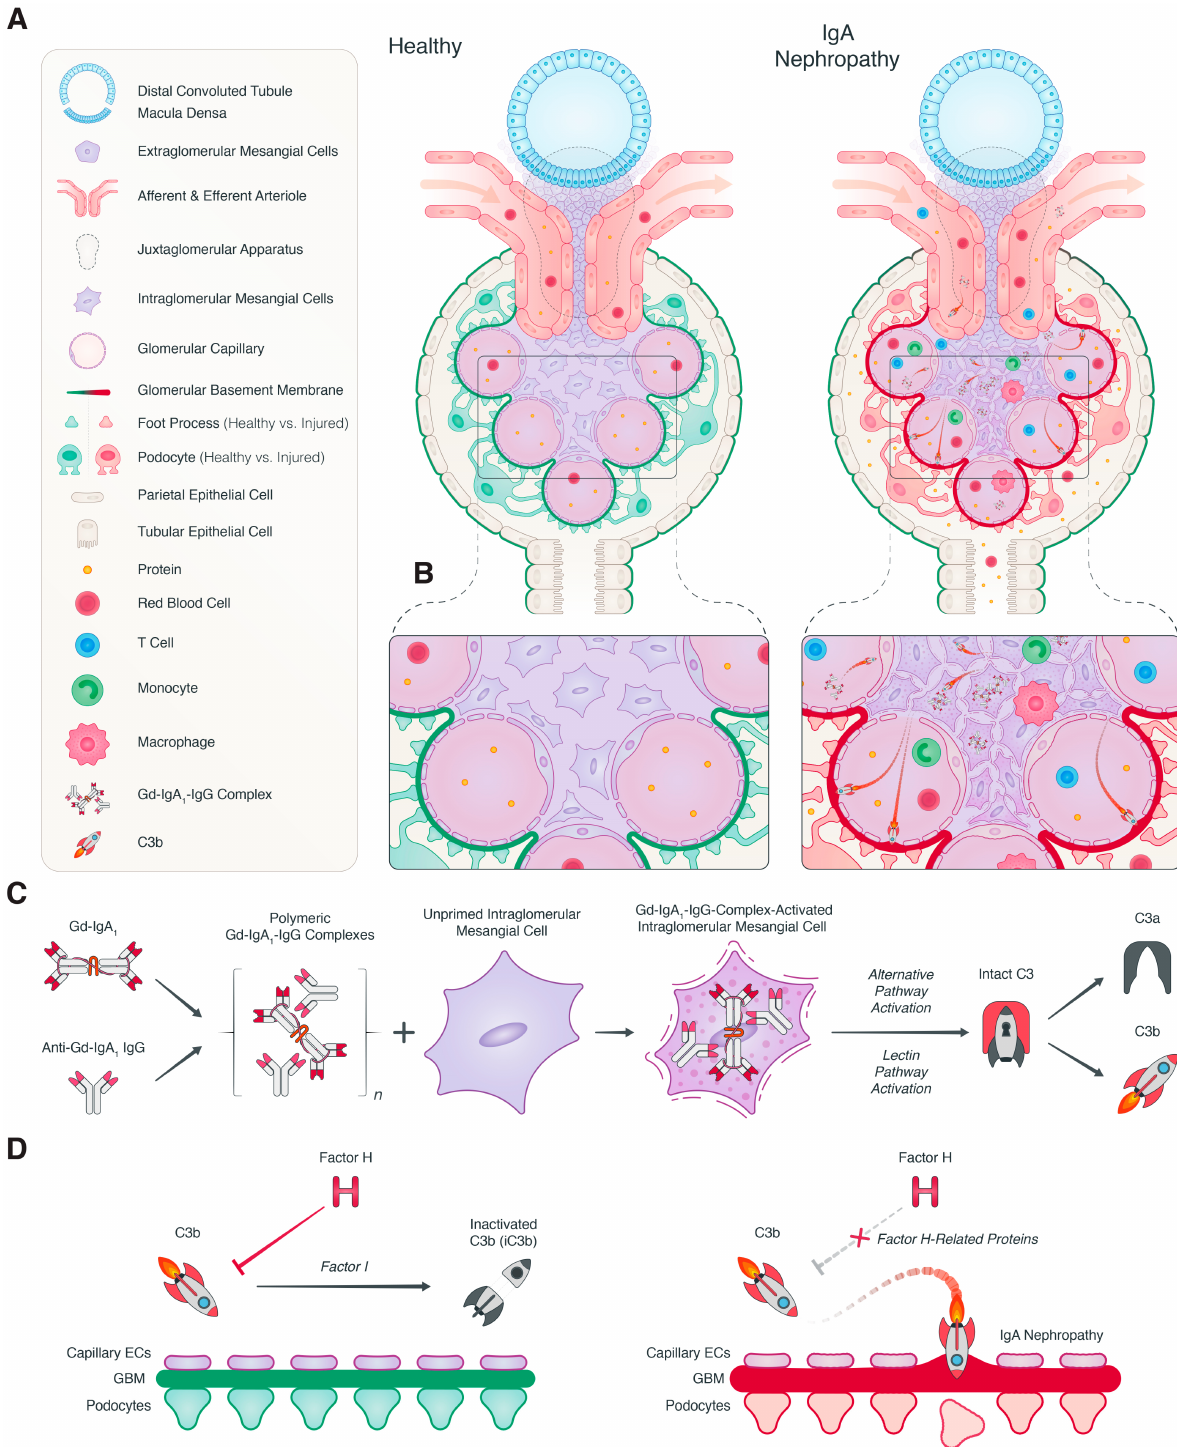
Figure 2. The role of complement activation in IgA nephropathy. ( A ) In a healthy glomerulus, filtration of blood occurs, and intact podocytes prevent the loss of proteins. In IgA nephropathy (IgAN), deposition occurs of immune complexes containing polymeric galactose-deficient IgA1 in the glomerular mesangium. ( B ) This leads to immune activation and induces proliferation of mesangial cells, increases the synthesis of extracellular matrix, and causes glomerular basement membrane (GBM) thickening, podocyte injury and protein loss. ( C ) Polymeric IgA1 and IgA1-containing immune complexes can activate both the alternative and lectin pathway, leading to the cleavage of intact C3, thereby forming C3a and C3b. ( D ) Factor H is a key regulator of the complement system, and together with Factor I, Factor H cleaves C3b to iC3b. Lastly, the Factor H-related proteins can compete with the regulatory functions of Factor H, thereby promoting complement